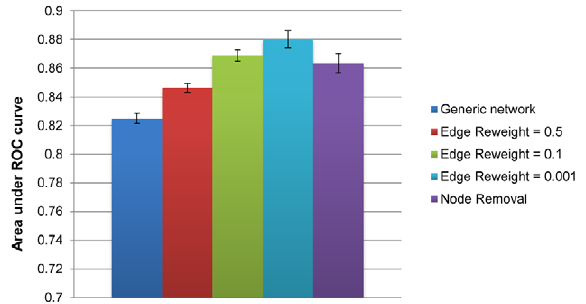
Figure 3. Comparing generic and tissue-specific PPIs’ perfor- mance in candidate disease genes prioritization. Performance comparison between the generic and different variants of tissue- specific PRINCE, according to the ROC Area under curve (AUC) of causal gene prediction in a leave-one-out cross validation test. Error bars represent the standard deviation of AUC values obtained when replacing leave-one-out with 25-fold cross validation of ten random partitions. Results are for a disease-tissue MAS threshold of